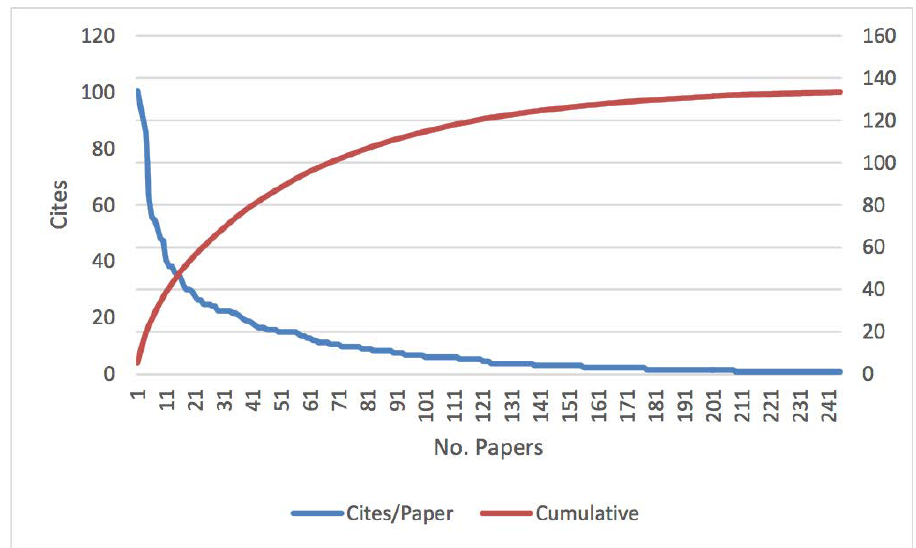
Figure 7. Pareto chart of